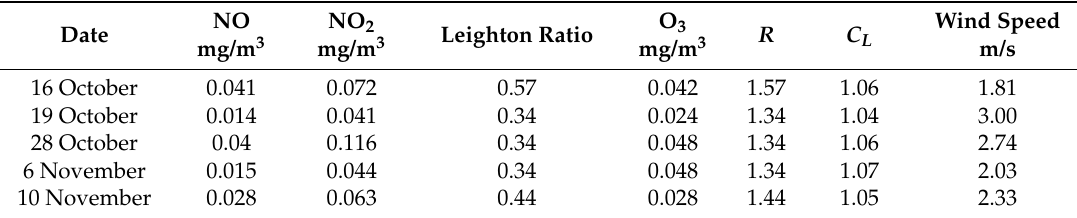
Table 3. NO, NO 2 , and O 3 concentration and the values of R and C L .